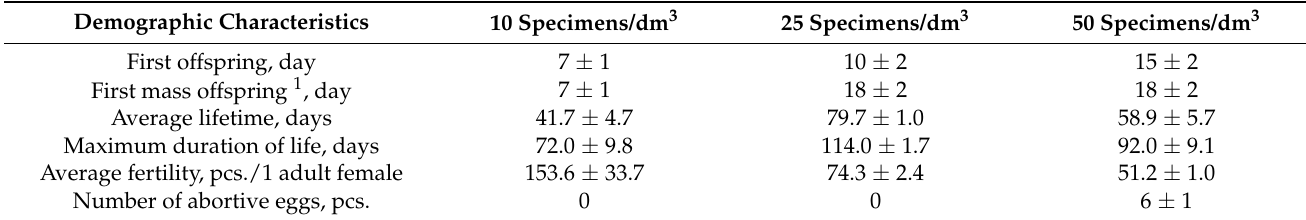
Table 1. Variation of demographic characteristics of D. magna culture depending on the density of the model